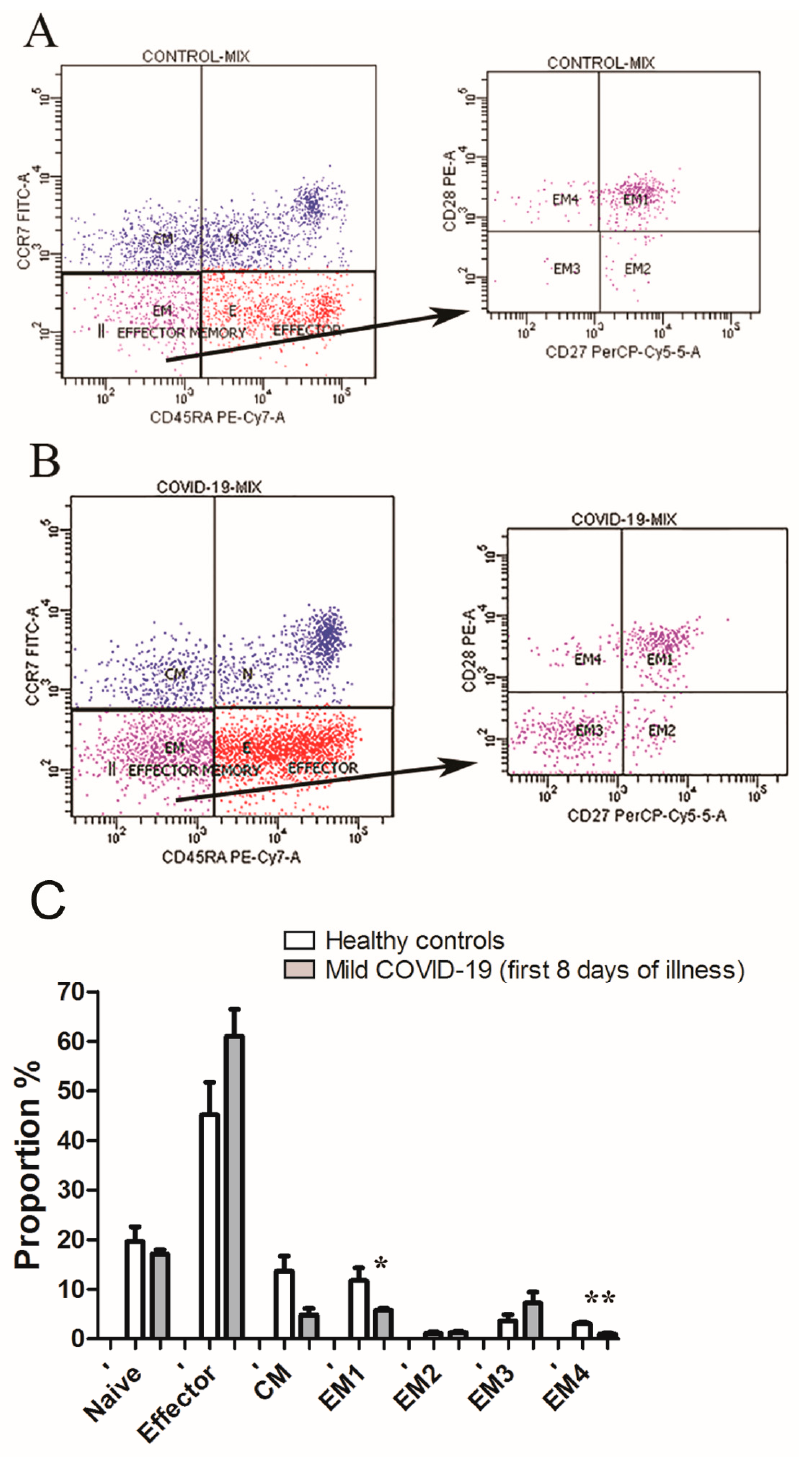
Figure 3. Flow cytometry analysis. ( A ) Differential expression of CD45RA, CCR7, CD27, and CD28 cell surface markers on total CD8+ T cells from healthy control ( n = 9) and ( B ) COVID-19 patients ( n = 12). CD3+CD8+ gated cells were separated into four subsets (naive, CM, EM, and effector) based on CD45RA and CCR7 labeling. Effector memory (purple) were analyzed for CD27 and CD28 co-expression, and the proportion of EM1, EM2, EM3, and EM4 cells was determined. ( C ) Proportion of naïve, effector, CM, EM1, EM2, EM3, and EM4 CD8+ T cells in healthy controls and mild COVID-19 patients within first eight days of illness. Data is presented as mean value ± standard deviation. Significant differences were indicated by p * = 0.06 and p ** < 0.001 (unpaired t test with Welch’s